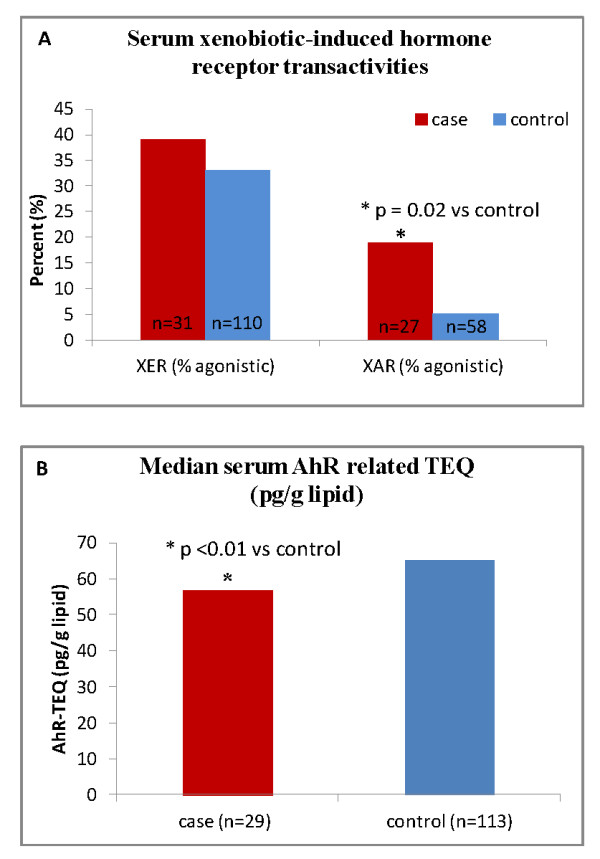
Levels of serum POP related xenobiotic induced transactivities of breast cancer cases and controls. A) serum xenobiotic agonistic induced ER and AR receptor transactivity; B) serum xenobiotic induced AhR transactivity (see legend to Table 3). % agonistic XER and XAR indicate a significant increase for the XER and XAR transactivity compared to the the solvent control. AhR-TEQ: AhR-TCDD equivalent. *: significant differences between cases and controls.